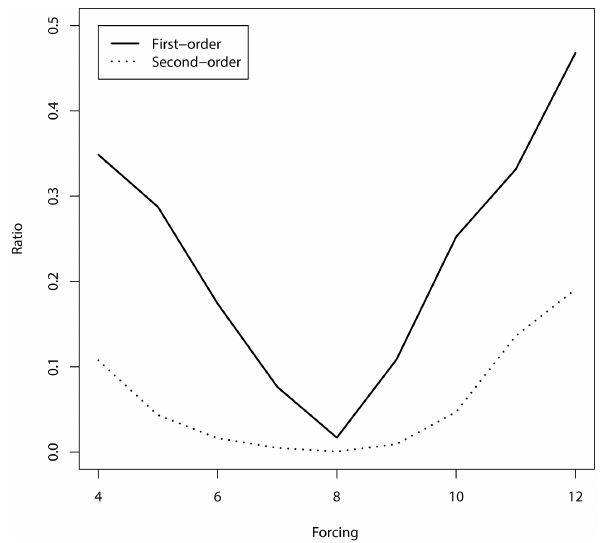
Figure 2. The proportions of residual ratios of the first-order (solid line) and second-order (dotted line) Taylor expansions over the non- linear observation operator x t interval [ − 0.1, 0.1], as a function of forcing F